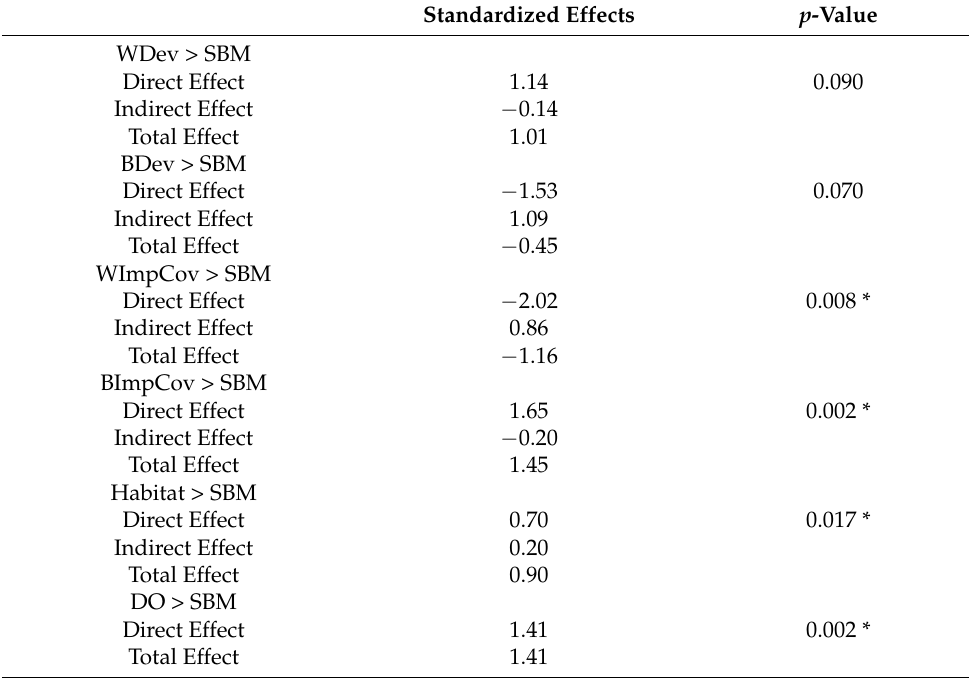
Table 5. Standardized direct, indirect, and total effects of sub-watershed developed (WDev), buffer developed (BDev), sub-watershed impervious cover (WImpCov), buffer impervious cover (BImpCov), habitat, and dissolved oxygen (DO) on the Streamside Biosurvey for Macroinvertebrates (SBM) scores as provided by the final path analysis using SPSS ® AMOS 20.